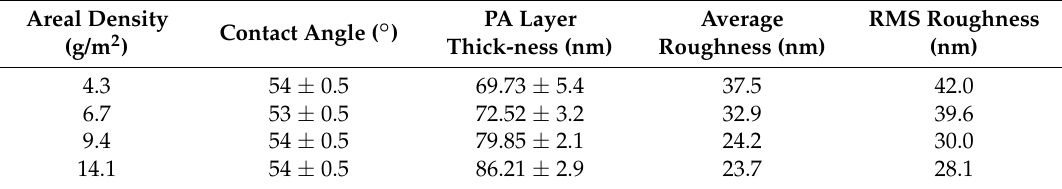
Table 4. Surface properties of nanofiber-based nanofiltration mebrane (NFNFM) prepared by different areal densities of HNM.